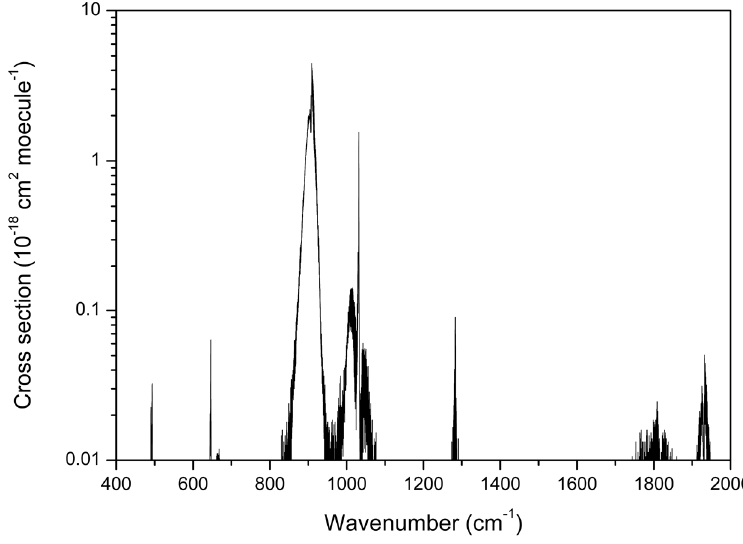
Figure 1. NF 3 absorption cross-section between 400 cm − 1 and 2000 cm − 1 .